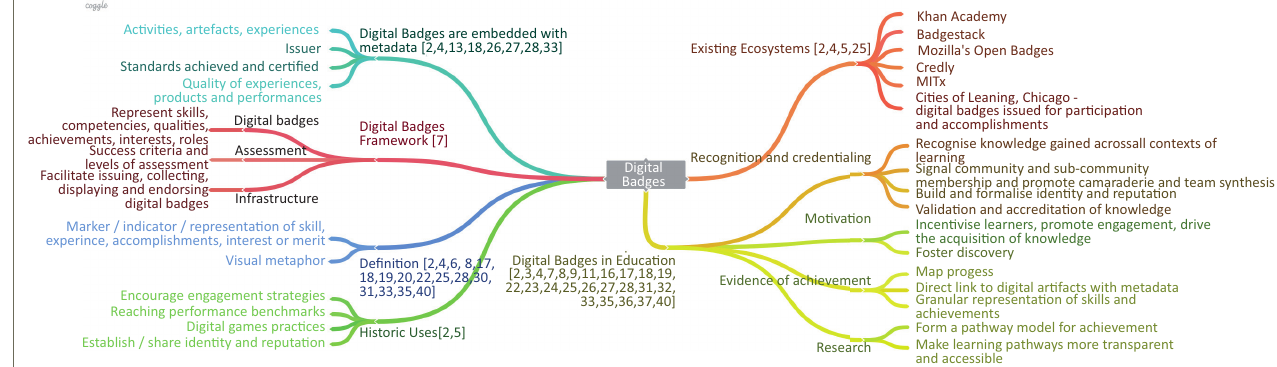
FIGURE 4: Overview of digital badges as extracted from the selected literature.